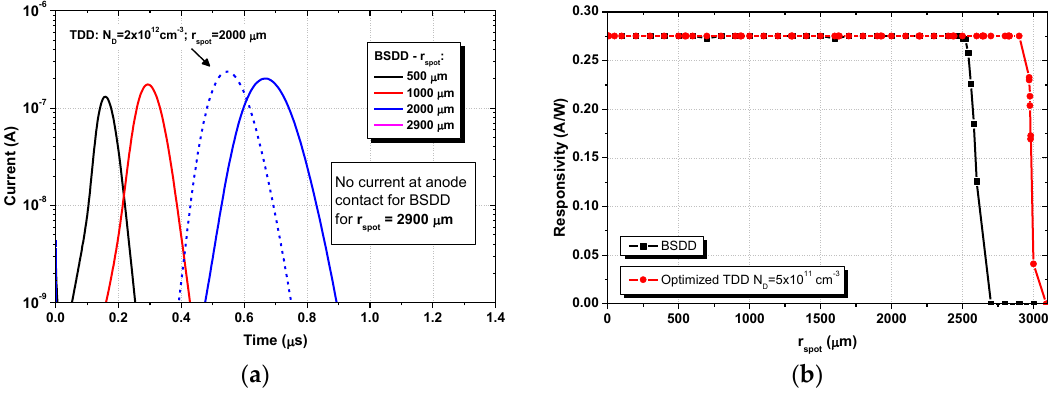
Figure 10. ( a ) Transient responses (solid lines) of a BSDD structure to a 150 eV light energy spot impinging at different positions r spot on the photodiode compared to that of a TDD; ( b ) Steady-state responsivity to a 150 eV light energy spot as a function r spot for a BSDD and a TDD.